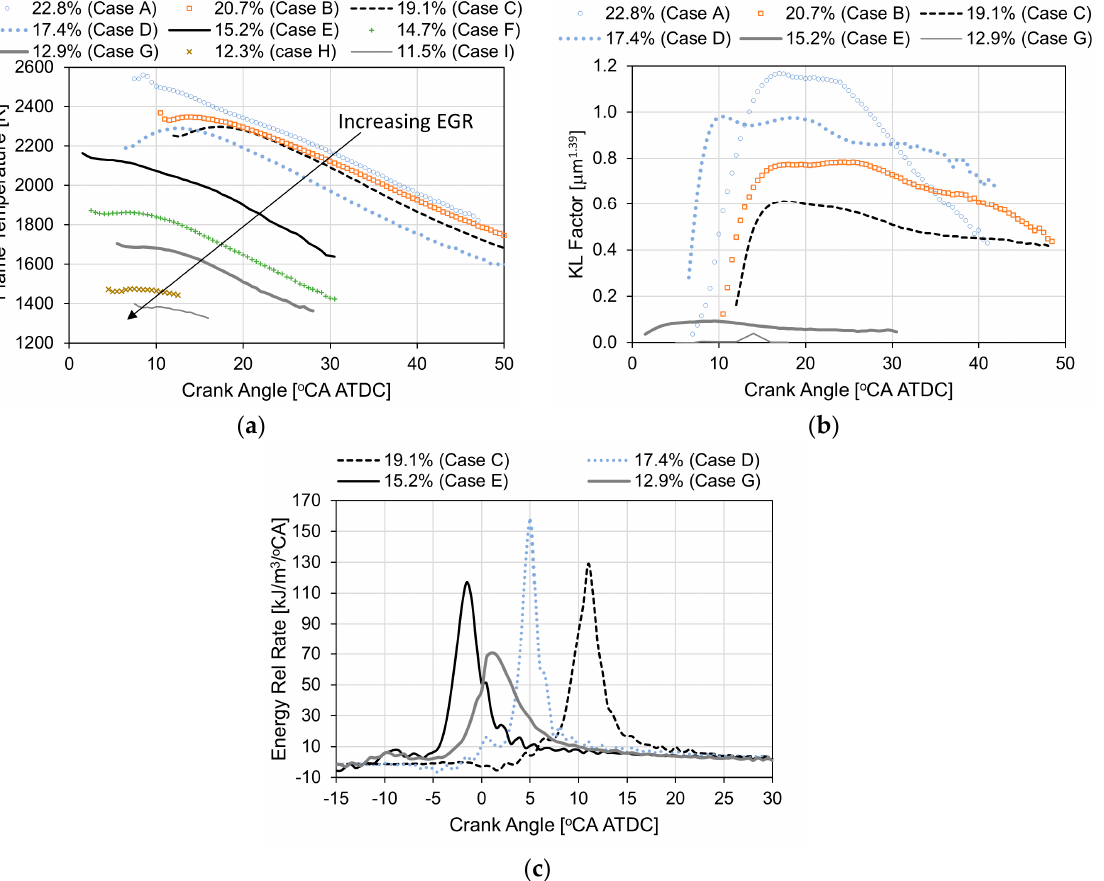
Figure 3. ( a ) Flame temperature during an EGR sweep at low load; ( b ) KL factor; ( c ) Energy release rate at selected operating points.